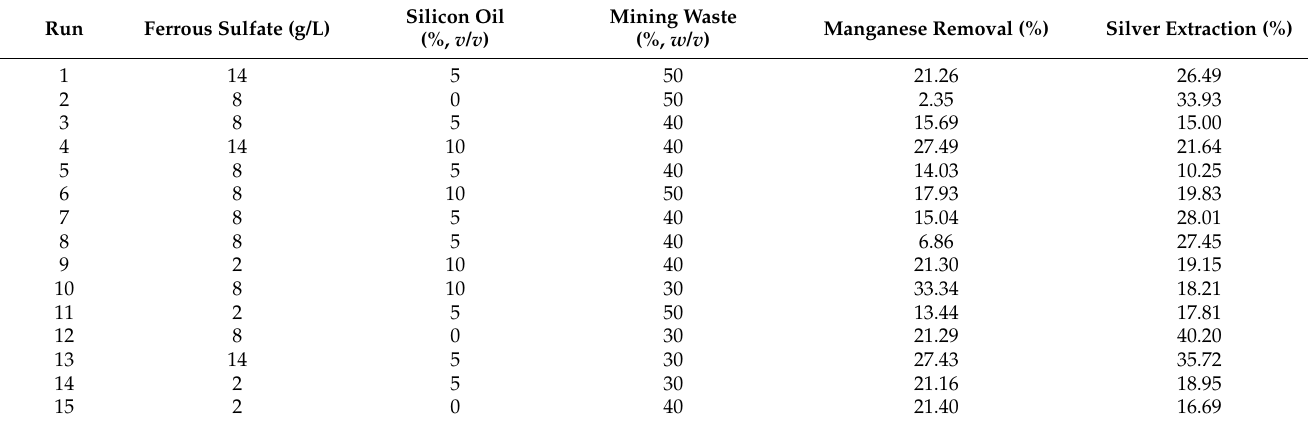
Table 3. Manganese removal and silver extraction after the bioleaching process using the response surface Box–Behnken experimental design.